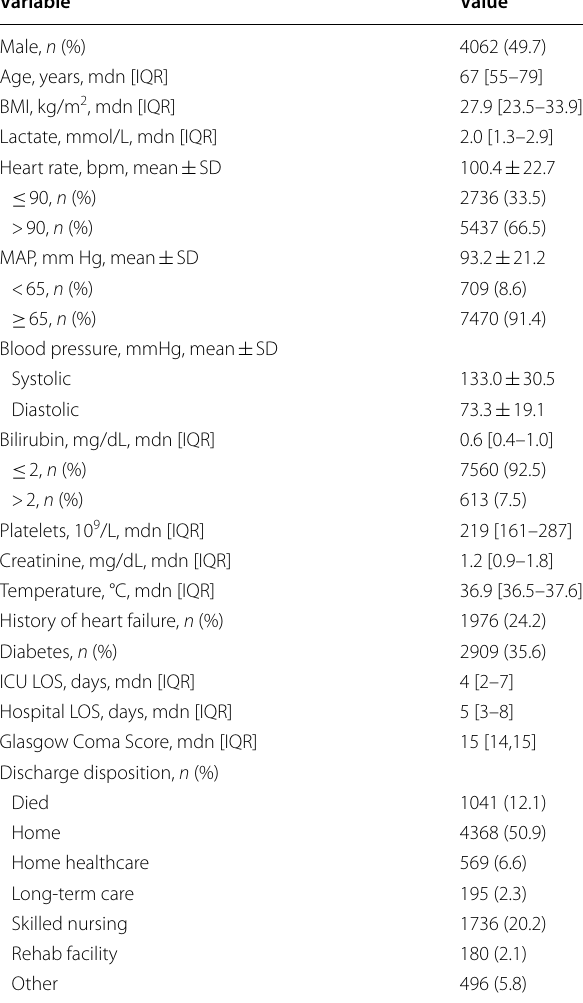
Table 1 Patient demographic and clinical characteristics